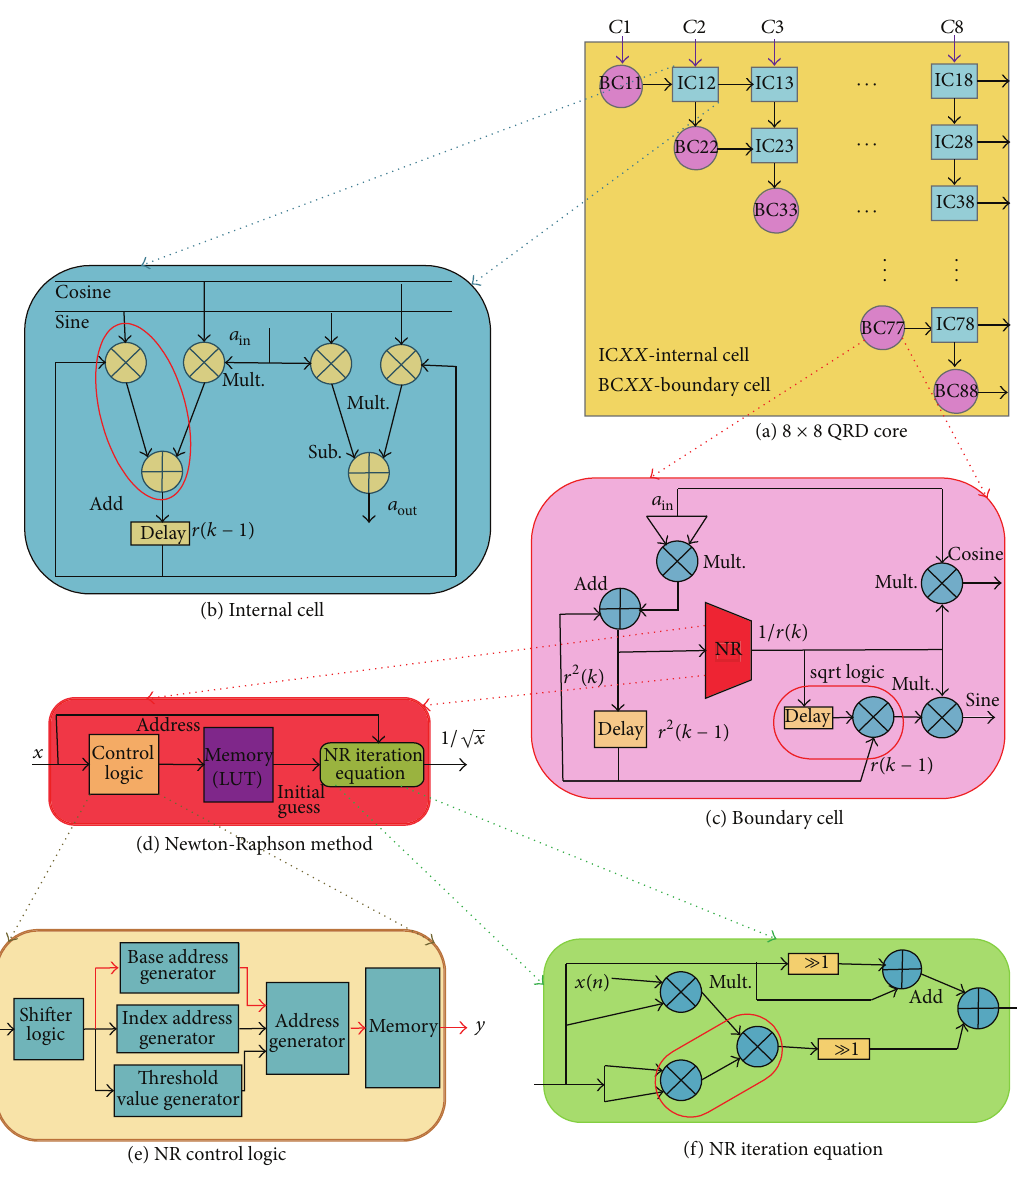
Figure 1: Block diagram representation of static 𝑚 × 8 QRD